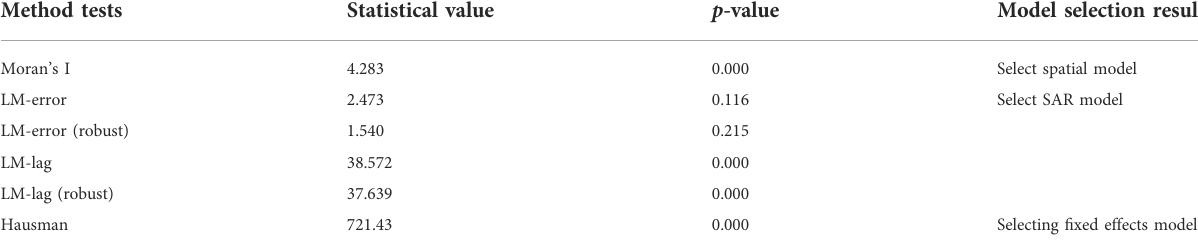
TABLE 3 Model setting